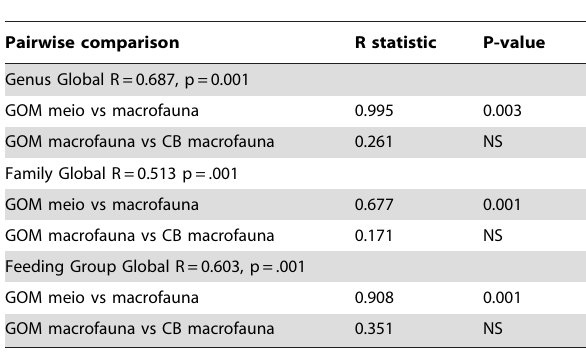
Table 1. Results of analysis of similarities (ANOSIM) of the Bray Curtis similarity matrices for meio- and macrofauna nematodes genera, family and feeding groups.